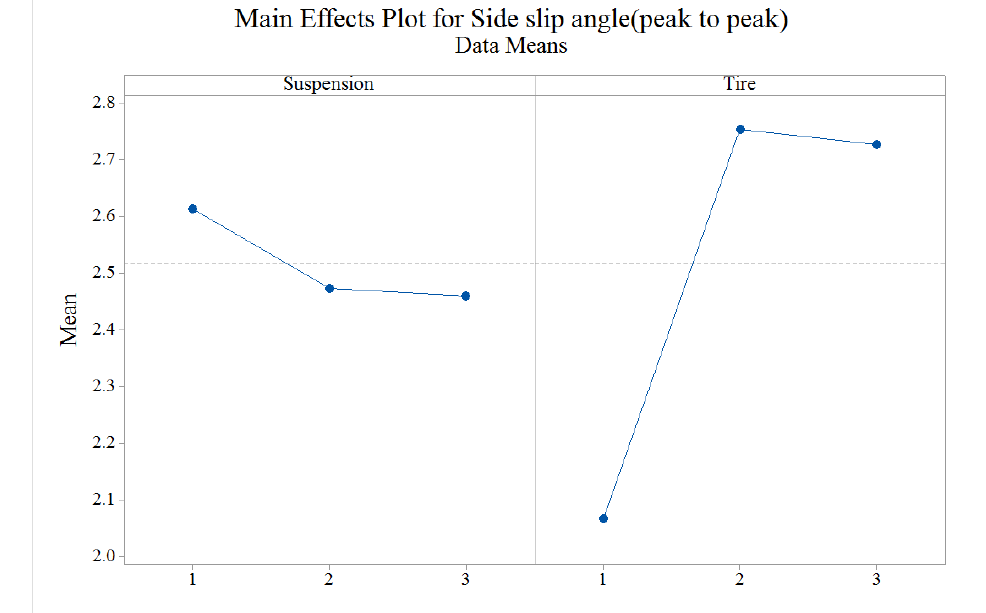
15 of 21 Figure 14. Suspension and tire test results (double-lane change; roll angle). Table 8. Suspension and tire test results (double-lane change; roll angle).